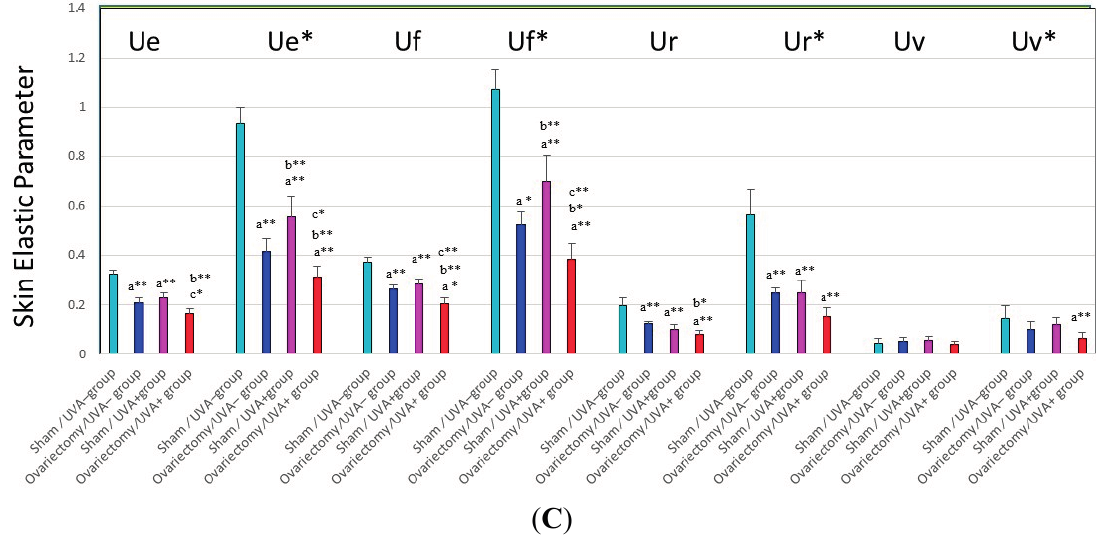
Figure 3. ( A ) Effects of ovariectomy with or without UVA irradiation on skin sagging. ( a ) Photographs after UVA irradiation (five times weekly for 12 weeks) of hairless mouse skin. White arrow shows distinctly increased sagging around the neck; ( b ) Visual scoring (scale = 0–3) of sagging after UVA irradiation. One week after the operations ( i.e. , when the mice were seven weeks old), half of the 96 mice were divided into six groups of eight mice each, as follows: (i) group 1, nonoperation/UVA nonirradiated (UVA − ) group; (ii) group 2, sham operation/UVA − group; (iii) group 3, ovariectomy/UVA − group; (iv) group 4, nonoperation/UVA irradiated (UVA+) group; (v) group 5, sham operation/UVA+ group; and (vi) group 6, ovariectomy/UVA+ group. The mice were irradiated using a bank of 12 Toshiba BL lamps with a glass filter (0.5 cm thick) for UVA (peak of emission near 351 nm, no emission below 320 nm, the irradiance between 320 and 380 nm corresponding to 93% of the total amount of UVA). The distance from the lamps to the animals’ backs was 35 cm. The animals were exposed to a UVA dose of 22.3 J/cm 2 /day, five times weekly, for 14 weeks; ( B ) Evaluation of sagging by pinch testing. ( a ) Photographs of pinch testing. Left : Mouse dorsal skin on the midline was picked up with the fingers as much as possible; Right : Photographs 1 s after the skin was released; ( b ) Recovery time in the pinch test using UVA exposed mice (five times weekly for 12 weeks). Data represent means ± SD; ( C ) Changes in skin elastic parameters after ovariectomy with or without UVA irradiation. Data represent means ± SD, n = 8. **, * p < 0.01, 0.05, a ( vs. sham/UVA − ); b ( vs. ovariectomy/UVA −